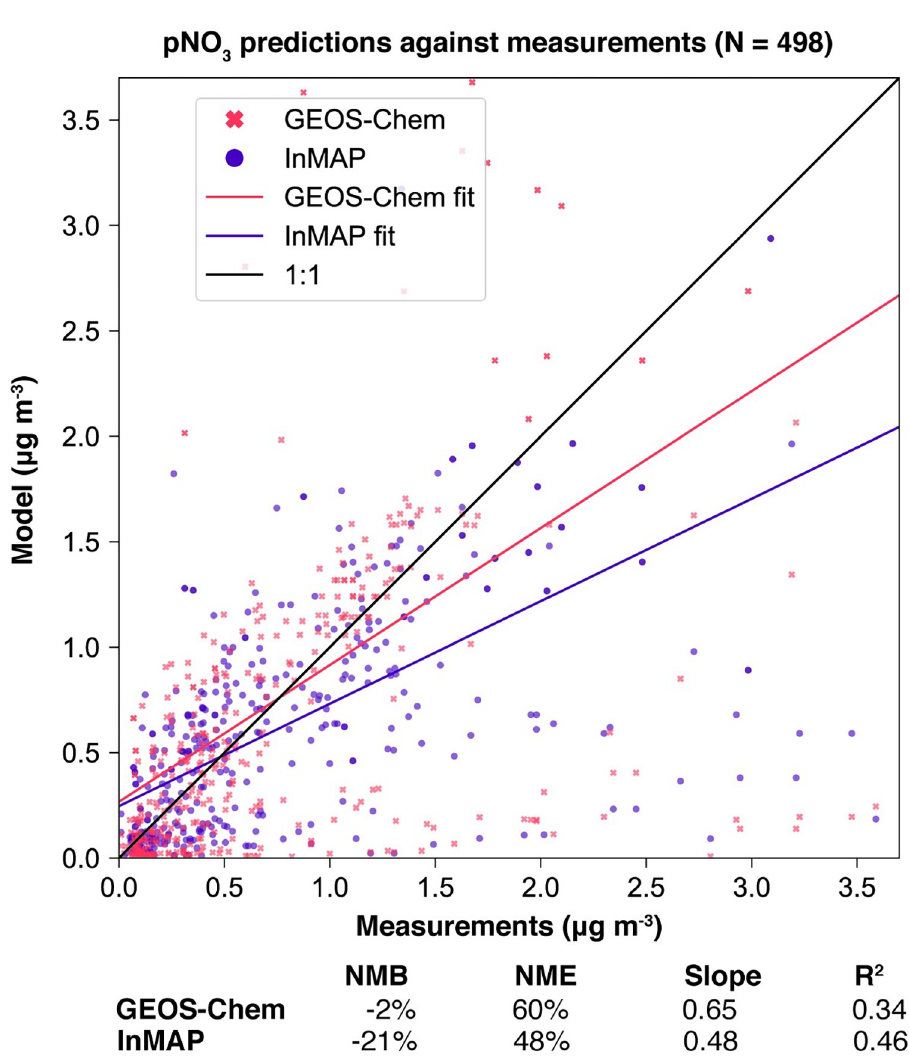
Fig 7. Global InMAP and GEOS-Chem annual-average pNO 3 concentrations against